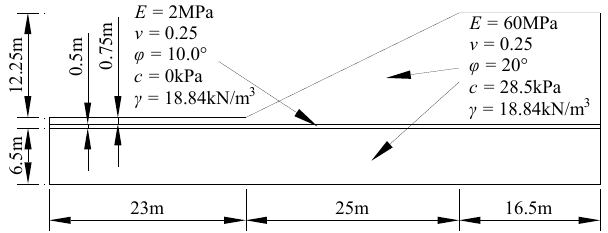
Figure 10. Dimension of the model in Example 2.